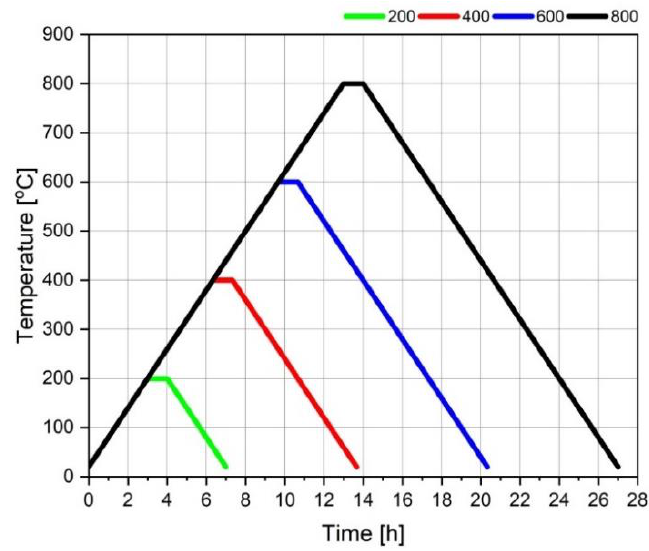
Figure 1. Heating and cooling regimes of the concrete specimens.